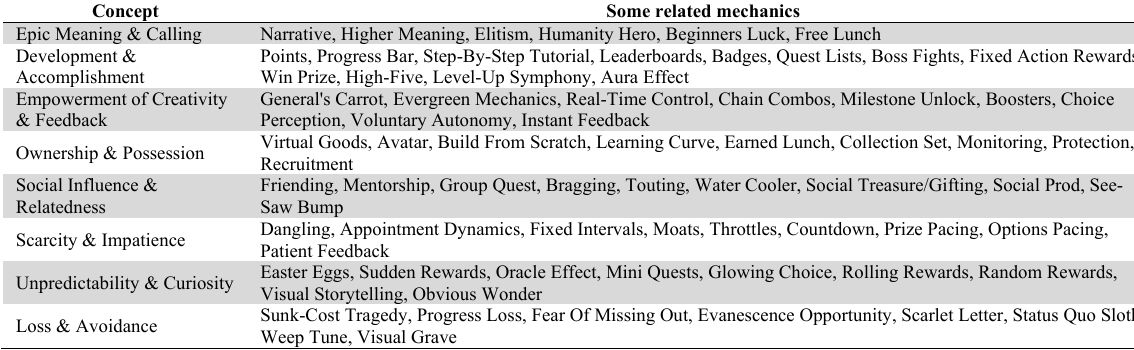
Table 3 Eight concepts of gamification according to Octalysis framework (Chou, 2015) Concept Some related mechanics Epic Meaning & Calling Narrative, Higher Meaning, Elitism, Humanity Hero, Beginners Luck, Free Lunch Development